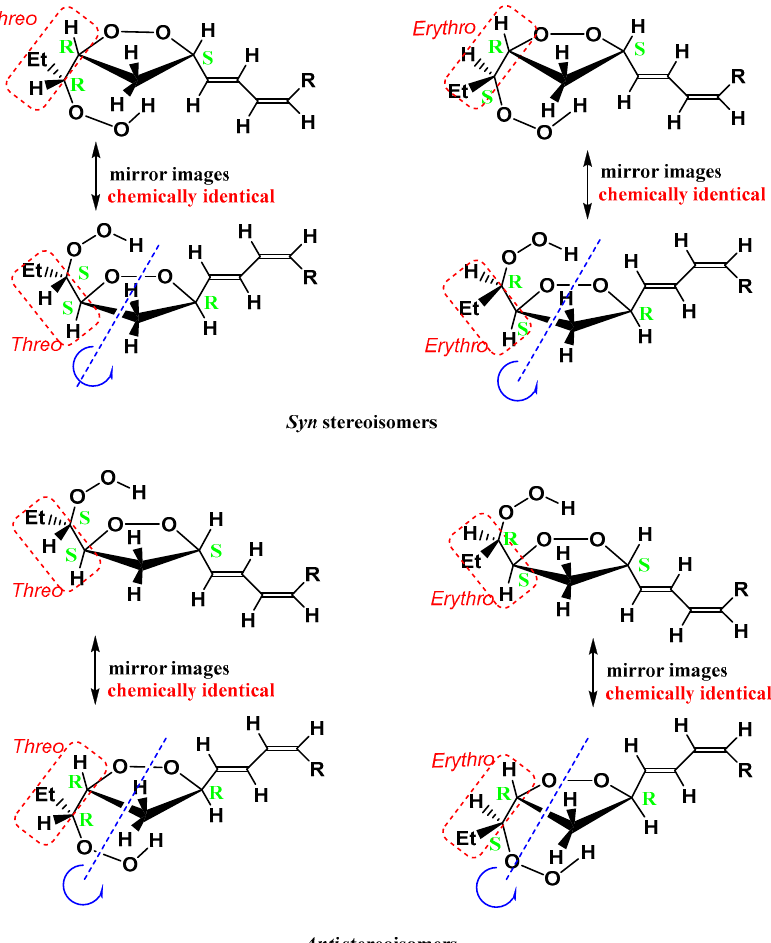
Figure 8. The 2 3 = 8 stereoisomers (2 3–1 = 4 pairs of enantiomers) of 9- cis , 11- trans , 16-OOH linolenate endo -hydroperoxides investigated in the present work.